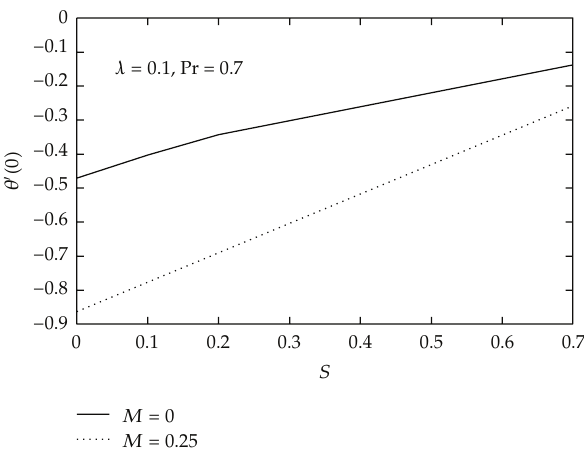
Figure 6: Heat transfer coe ffi cient θ (cid:4) (cid:6) 0 (cid:7) against the stratification parameter S for two values of the curvature parameter M when λ (cid:9) 0 . 1 and Pr (cid:9)